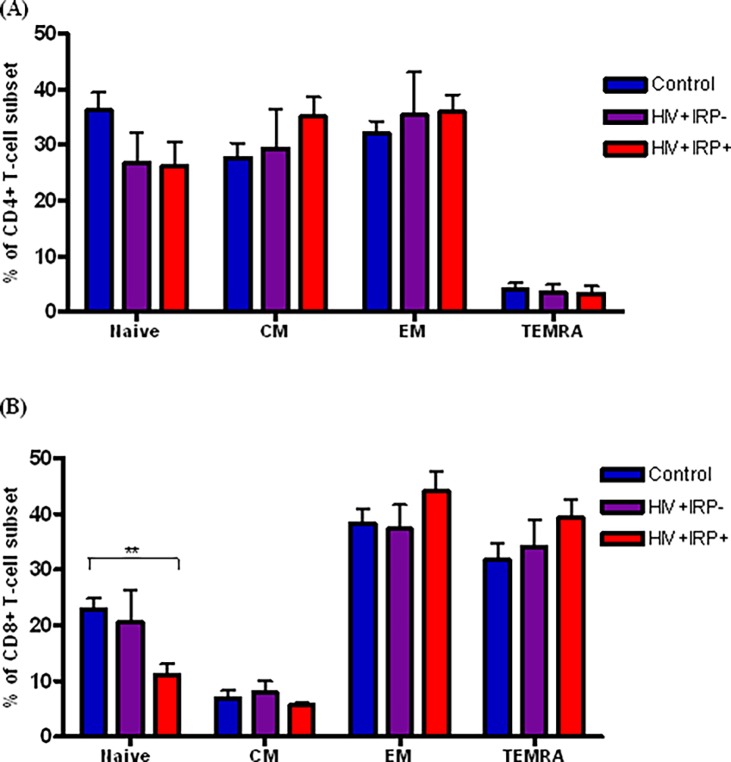
Relationship between the IRP and T-cell subset distribution.Percentages of naive (CD45RA+ CD28+CCR7+), central memory (CD45RA-CD28+CCR7+), effector memory (CD45RA- CD28-CCR7-) and terminally differentiated effector memory (TEMRA) (CD45RA+CD28- CCR7-) T-cells were assessed within the CD4+ (A) and CD8+ (B) T-cell compartments. Comparisons were made between the frequency of these subsets in uninfected controls (blue), HIV+IRP- (purple) and HIV+IRP+ (red). Statistical significance was determined using the Mann–Whitney U test. *p<0.05, **p<0.01, ***p <0.001.